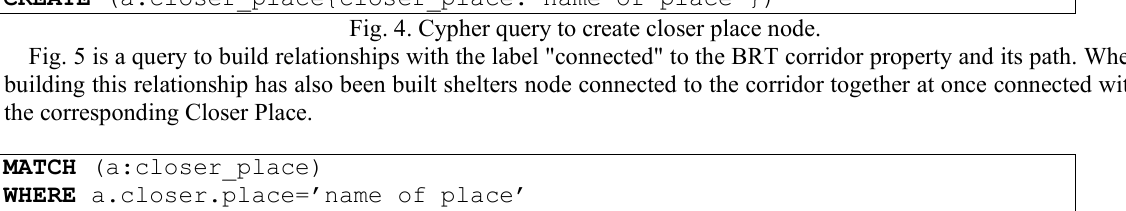
Fig. 4. Cypher query to create closer place node.